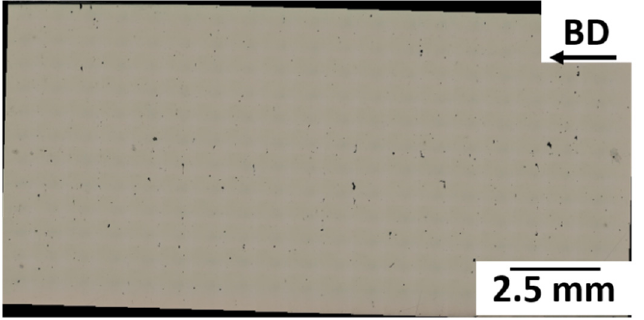
Figure 4. Optical micrograph of the as-built sample showing pores (black regions). BD is the build direction.